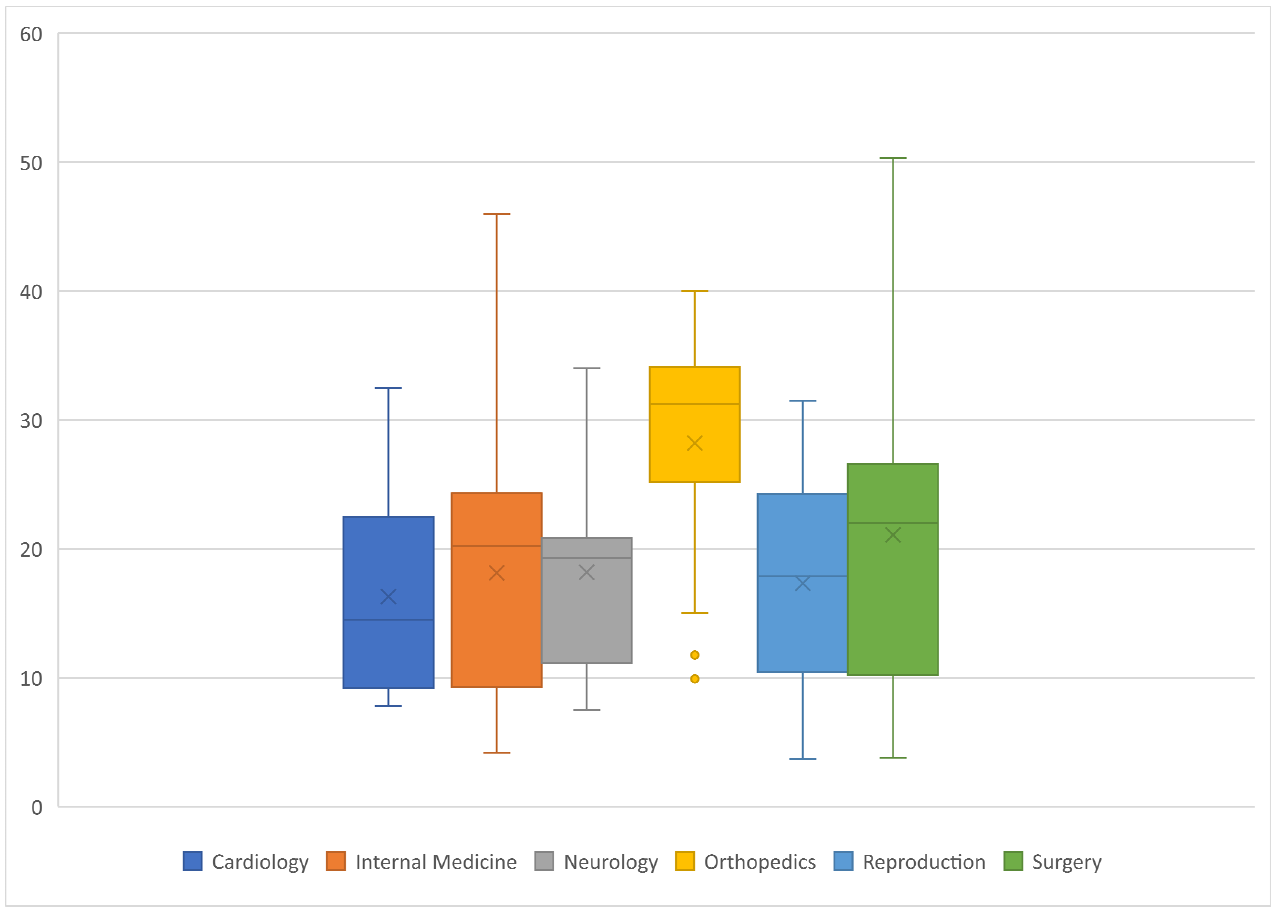
Figure 4. Weight (in kg) of the dogs utilized in 150 clinical trials within six veterinary specialties (25 each). (25